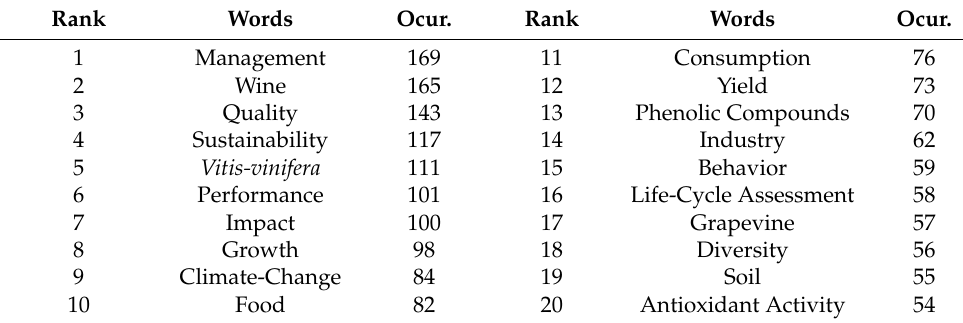
Table 9. Keywords most frequently used by authors.